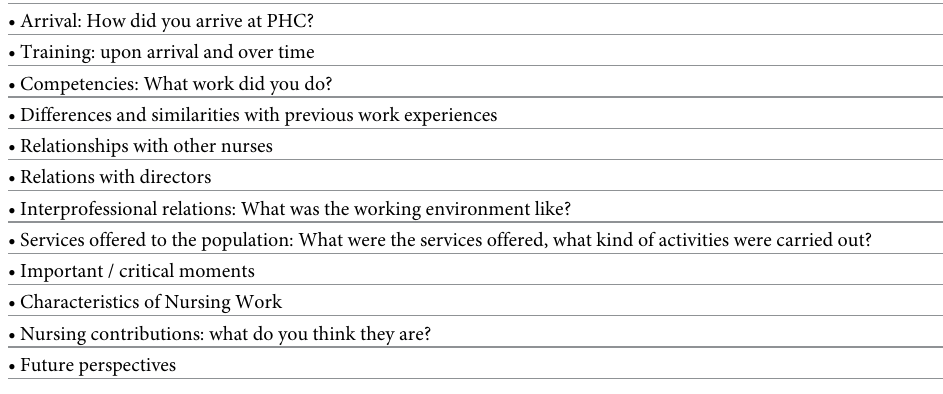
Table 1. Interview script